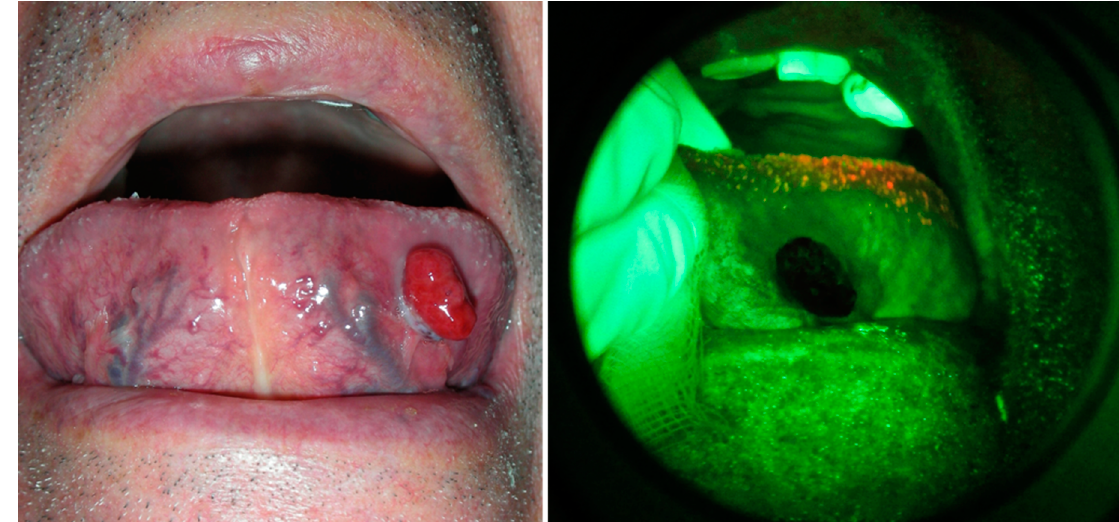
Figure 2. VELscope ® results before a tongue biopsy. COE vs. VELscope ® . For gentle concession of Prof. L. Laino.